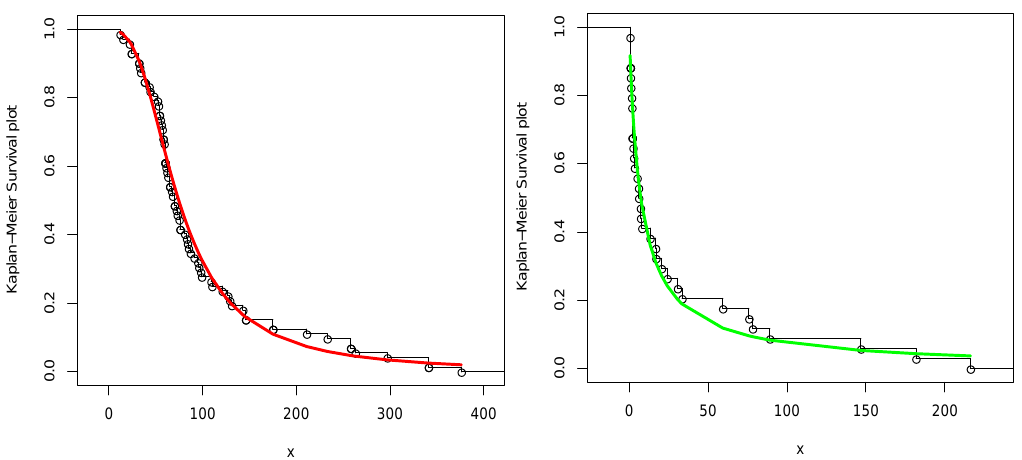
Figure 10. KMS plots of the GAEPPR model for (a) the strength glass fiber data ( left ) (b) the runoff data ( right